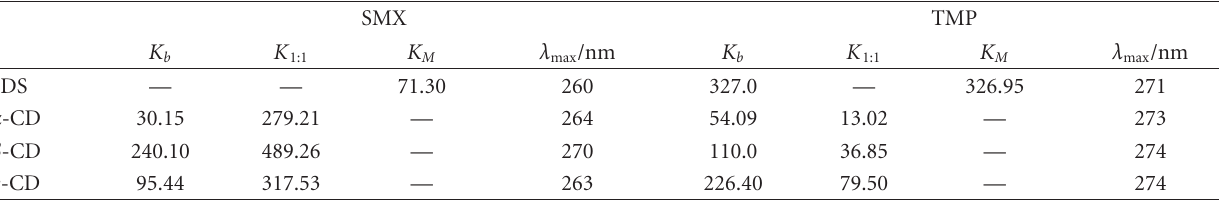
Table 1: K 1:1 and K M values for SMX and TMP in the presence of SDS and CDs at 298 K. K b and λ max (nm) values for fixed concentration of SMX and TMP (4 . 0 × 10 − 5 M) obtained in SDS and CDs.